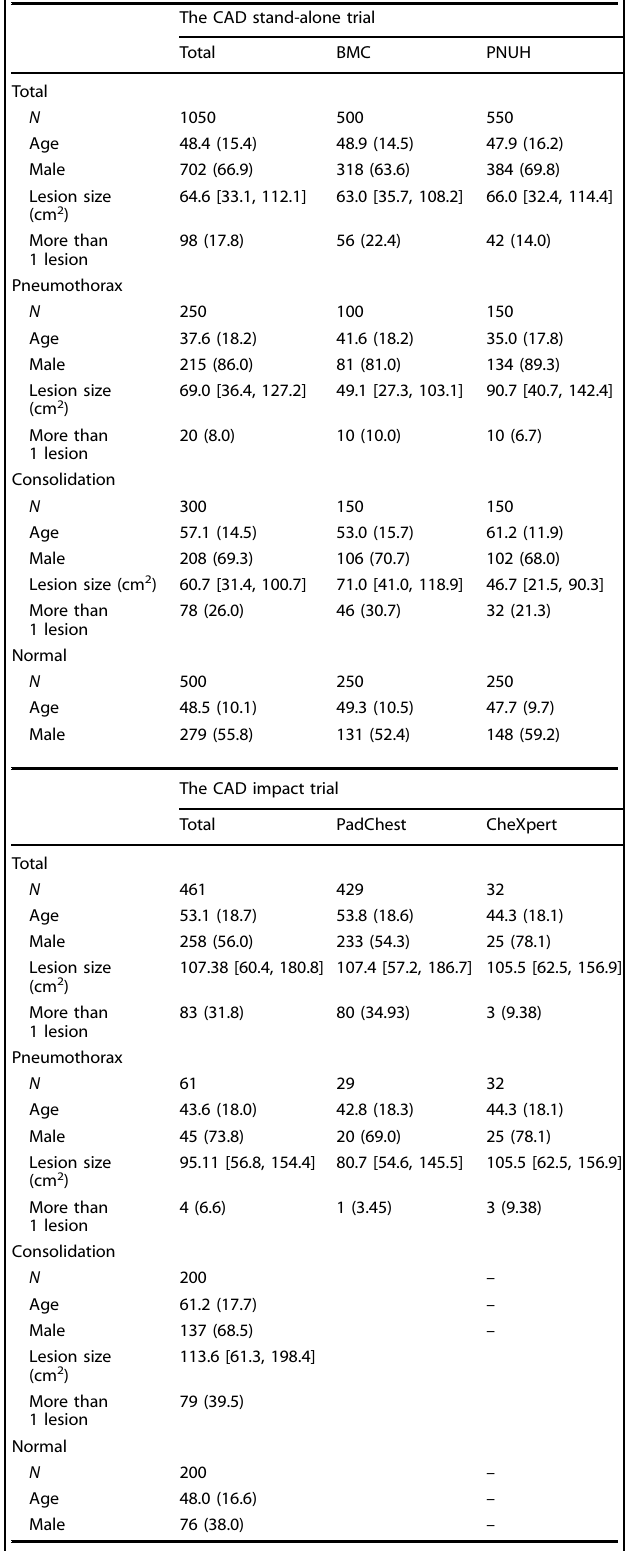
Table 1. Sample characteristics for the two trials by data sources and